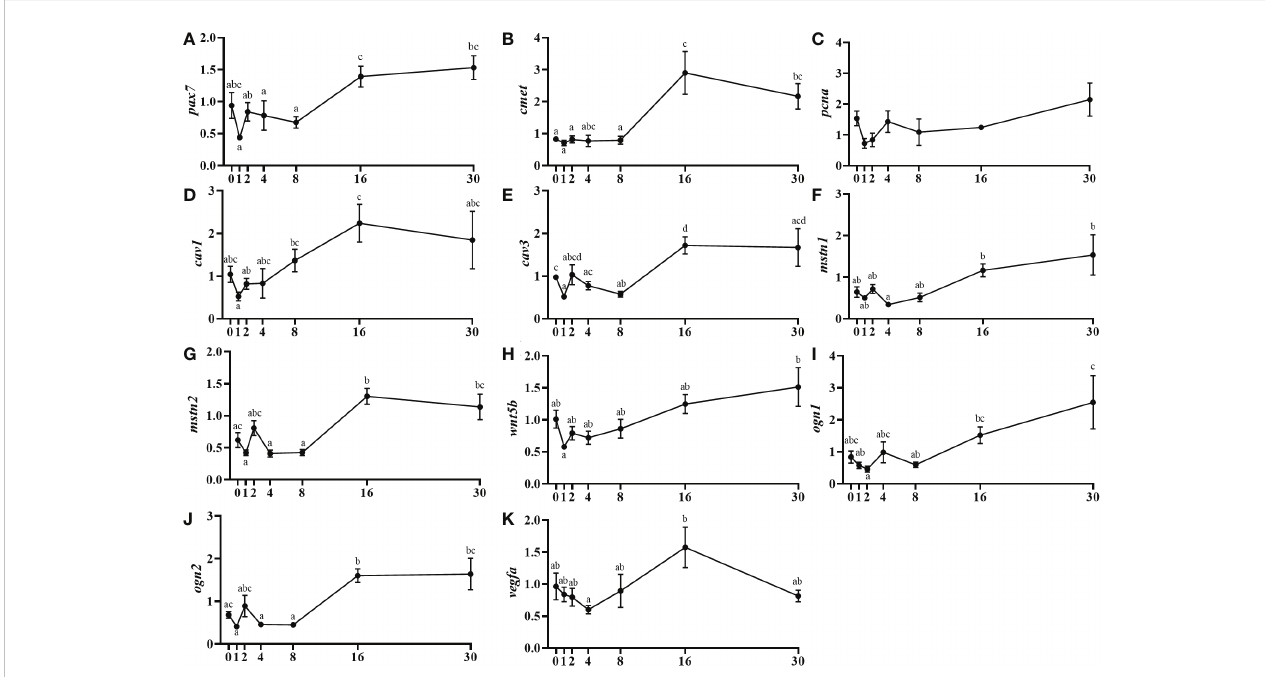
FIGURE 4 Relative gene expression of other muscle-related markers involved in muscle regeneration, pax7 (A) , cmet (B) , pcna (C) , cav1 (D) , cav3 (E) , mstn1 (F) , mstn2 (G) , wnt5b (H) , ogn1 (I) , ogn2 (J) , and vegfa (K) in injured epaxial muscle of fi sh. Data are shown as means ± SEM, n=10. Statistical analysis was assessed by one-way ANOVA. Different letters indicate signi fi cant differences of factor time (days post-injury) (Tukey ’ s HSD or Games-Howell post-hoc test, p < 0.05).